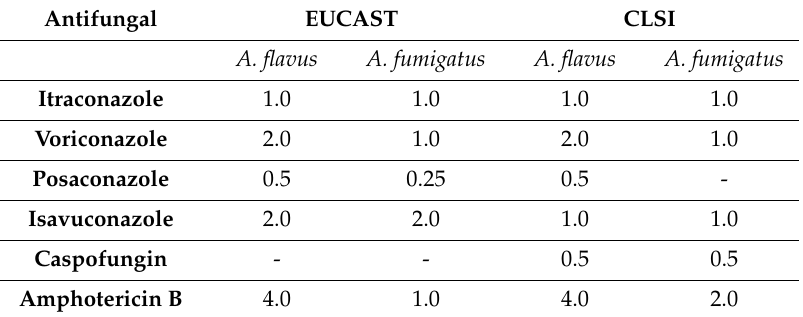
Table 2. Epidemiological cuto ff values ( µ g / mL) defined for Aspergillus flavus and A. fumigatus by Clinical Laboratory Standard Institute (CLSI) [135] and European Committee on Antimicrobial Susceptibility Testing (EUCAST)